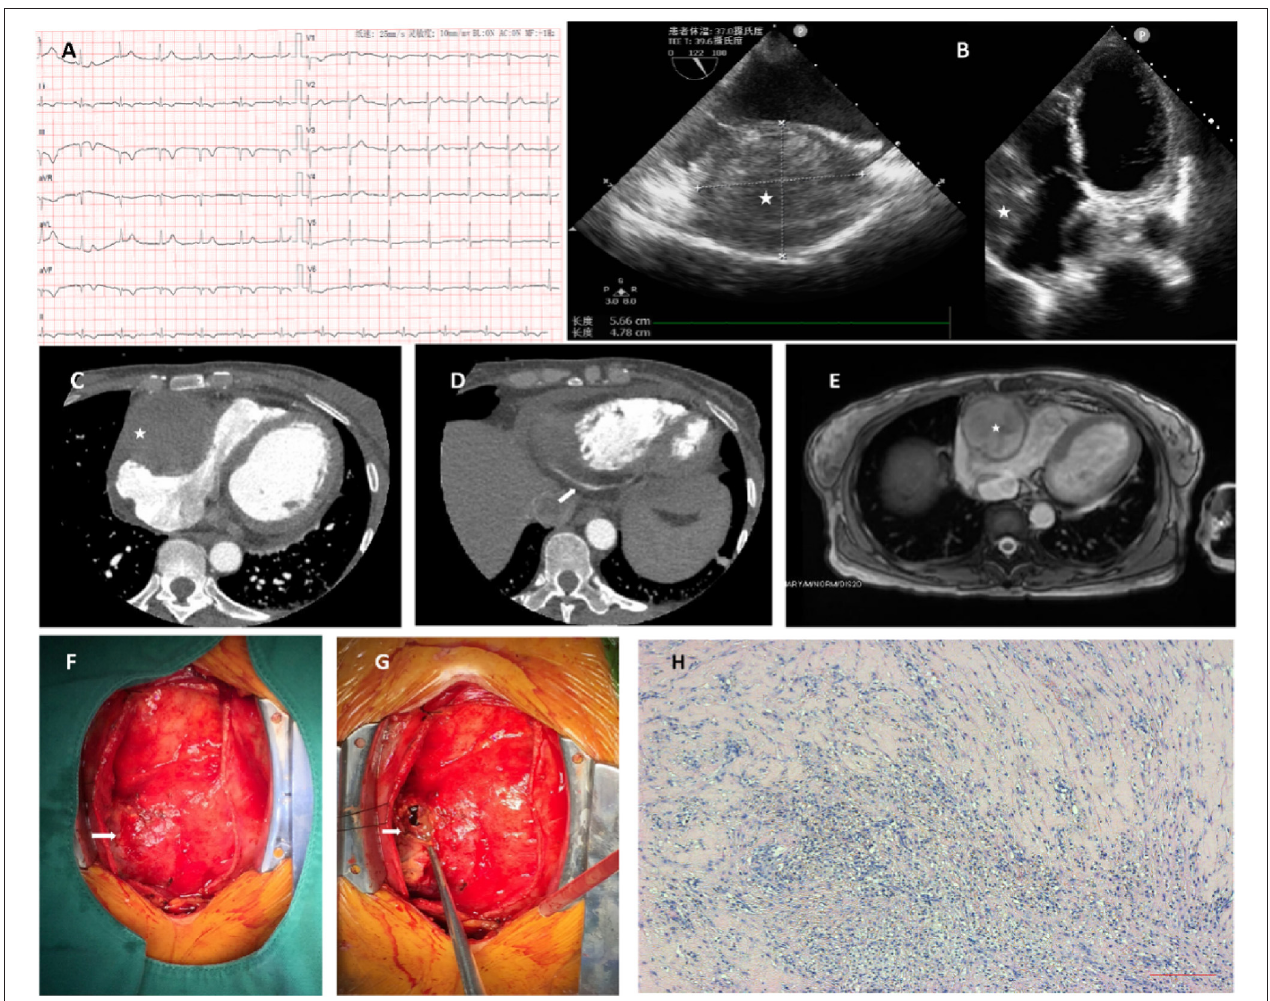
FIGURE 1 | (A) ECG shows Q-waves in II, III, aVF leads, and left axis deviation, indicating inferior myocardial infarction. (B) A large (59 × 53mm), heterogeneous mass detected on transthoracic echocardiography (TTE) located in the right atrioventricular groove. (C) Computed tomographic angiography (CTA) shows a spherical, mixed-density mass (5.4 × 5.5cm) located at the anterior wall of the right atrium. (D) With coronary artery CTA, the proximal right coronary artery is not possible. Contrast filling can be detected in the distal part of the artery. (E) Cardiac MRI manifests a large (5.6 × 5.1 × 5. cm), round, mixed-signal mass located in the right atrioventricular groove. The right atrium and the right ventricle are compressed, and the ejection fractions (EFs) of the left and right ventricles are 36.1 and 40.1%, respectively. (F) The oval, cystic, under epicardium hematoma, is revealed out-punching from the right atrioventricular groove through pericardiotomy. The hematoma was partially incised, and the thrombus and abscess were found and evacuated. (G) The histopathological report demonstrates fibrosis with the additional presence of inflammatory cells. (H) The content was thrombus, with a plethora of neutrophil granulocytes inside.